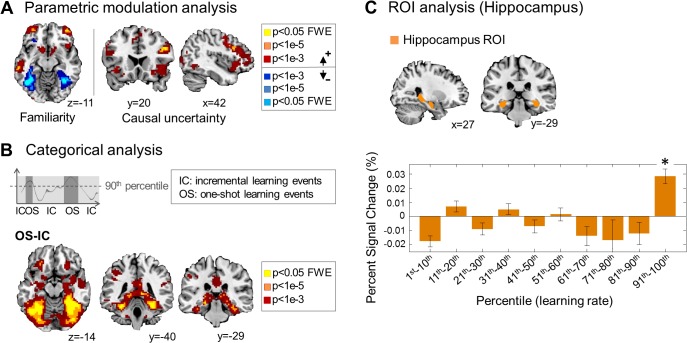
Neural correlates of one-shot-learning–related computations.(A) Neural substrates of familiarity and uncertainty processing in one-shot learning. Anterior lateral prefrontal cortex, dorsal prefrontal cortex, and parietal lobe encode signals associated with cue familiarity, whereas the fusiform gyrus encodes a cue novelty signal. Ventrolateral prefrontal cortex and parts of dorsomedial prefrontal cortex encode causal uncertainty signals. Effects significant at p < 0.05 (FWE corrected) are shown in yellow. (B) Involvement of the hippocampal memory system during one-shot learning. “One-shot learning events” is the collection of events during which the model predicts rapid learning (>90th percentile), and “incremental learning events” is the collection of events during which the model predicts otherwise (<90th percentile). Shown are significant categorical effects for one-shot learning events (OS) > incremental learning events (IC). We did not find any significant categorical effects for IC > OS, even with the liberal threshold p = 0.01 uncorrected. Effects are significant in fusiform gyrus, hippocampus, and parahippocampal gyrus. (C) Region-of-interest (ROI) analysis. We used an anatomically defined hippocampus to construct an ROI mask [54] (top), which includes CA1–CA3, dentate gyrus, and the hippocampal-amygdala transition area. Blood-oxygen-level dependent (BOLD) activity in the hippocampal ROI increases significantly in OS (91st–100th percentile of learning rate) but not in IC (1st–90th percentile) (paired-sample t test p < 1e-8). The asterisk shows the statistical level at which the signal change is significantly different from the baseline after Bonferroni adjustment for multiple comparisons across the ten learning bins (one-sample t test; *: p < 1e-6). Error bars are SEM across subjects.